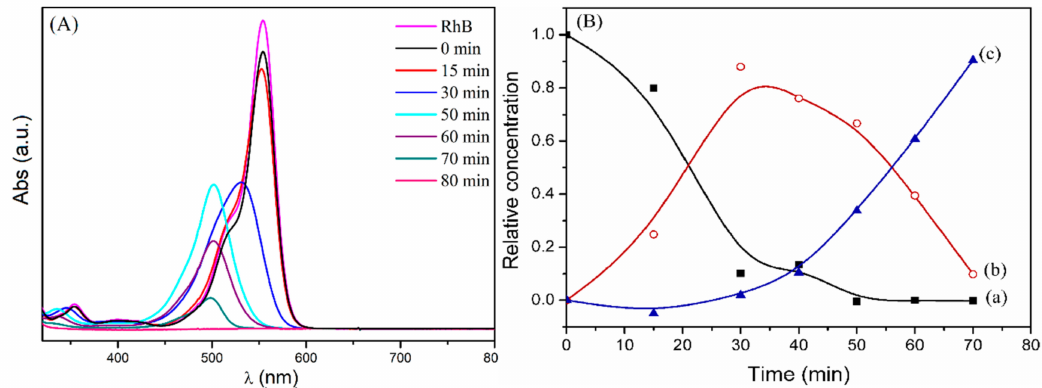
Figure 5. Photodegradation of 10 − 5 M Rhodamine B (RhB) solution by AgCl. ( A ) Temporal evolution of UV–Vis spectra; ( B ) relative concentration of RhB (a), de-ethylated species (b), and cleaved species